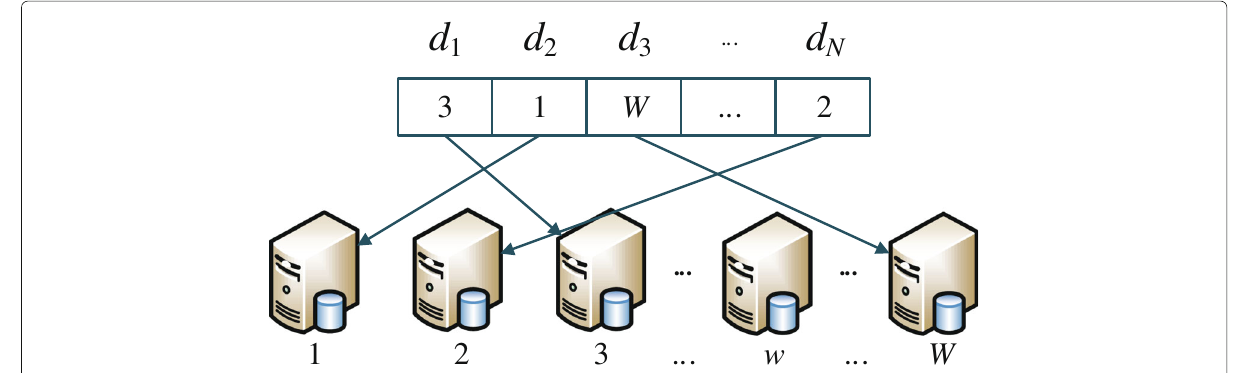
Fig. 2 An encoding instance of W physical machines for N meteorological